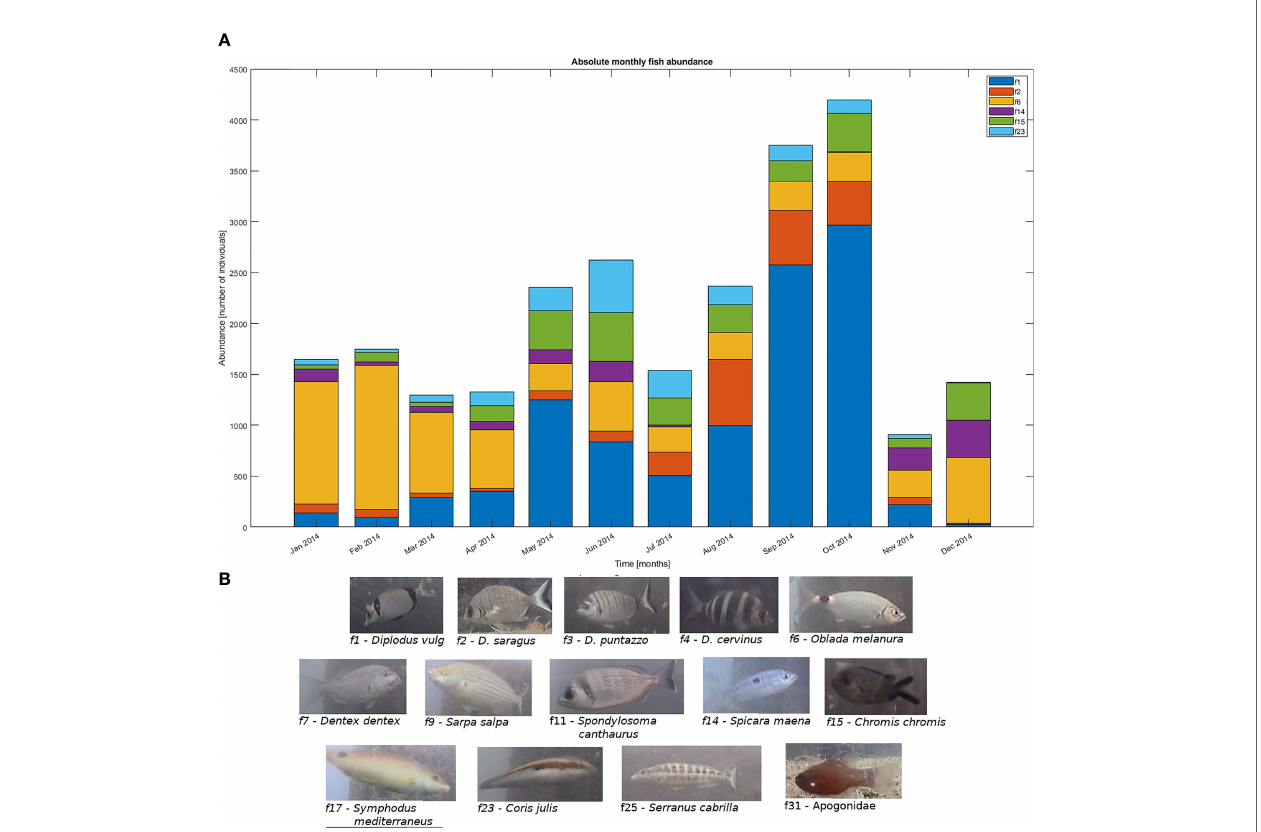
FIGURE 2 | (A) Temporal distribution of the species covering the 90% of the whole set of species reported in Table 2 ; (B) Representative individuals of the fi sh species presented in Table 2